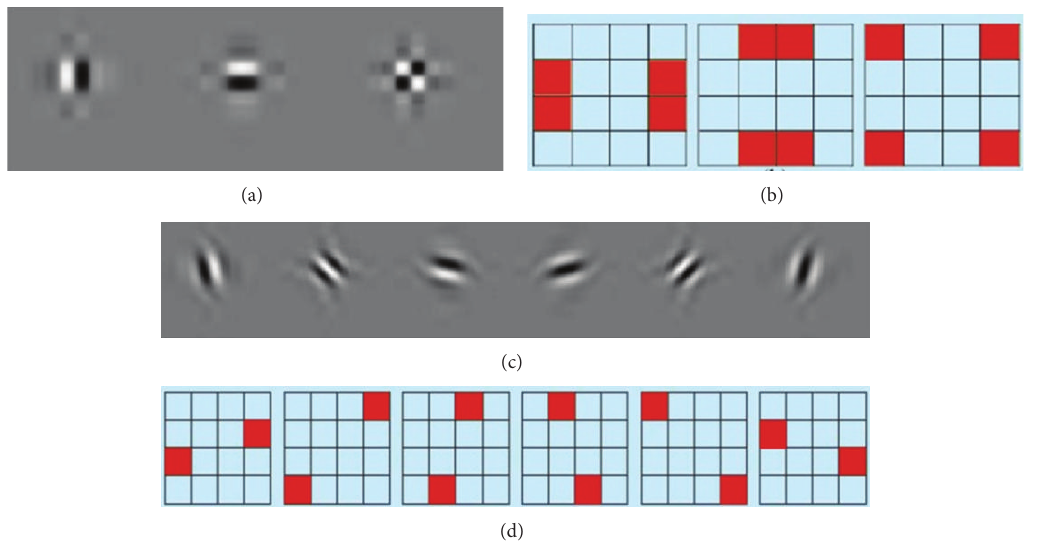
Figure 15: A comparison between subbands of DWT and DCWT. (a) The wavelets in the space domain (LH, HL, and HH). (b) The idealized support of the Fourier spectrum of each wavelet in the 2D frequency domain. We can see the checkerboard artifact of the third wavelet. (c) The complex wavelets in the space domain. (d) The idealized support of the Fourier spectrum of each wavelet in the 2D frequency plane. The absence of the checkerboard phenomenon is observed in both the space and frequency domains